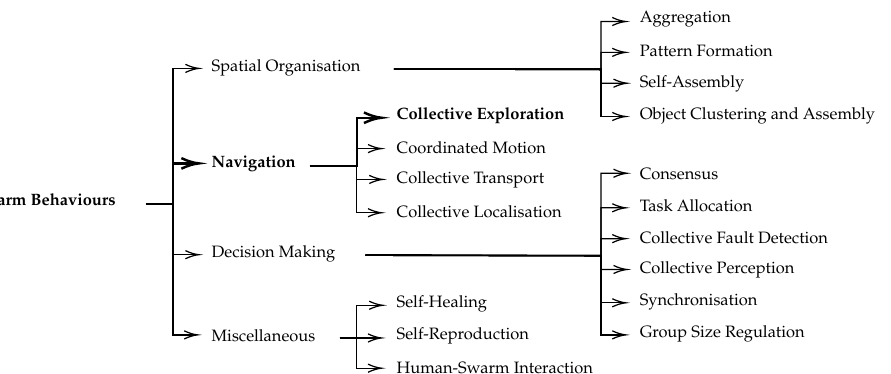
Figure 1. Classification of swarm behaviours proposed by Brambilla et al. [5] and extended by Schranz et al.